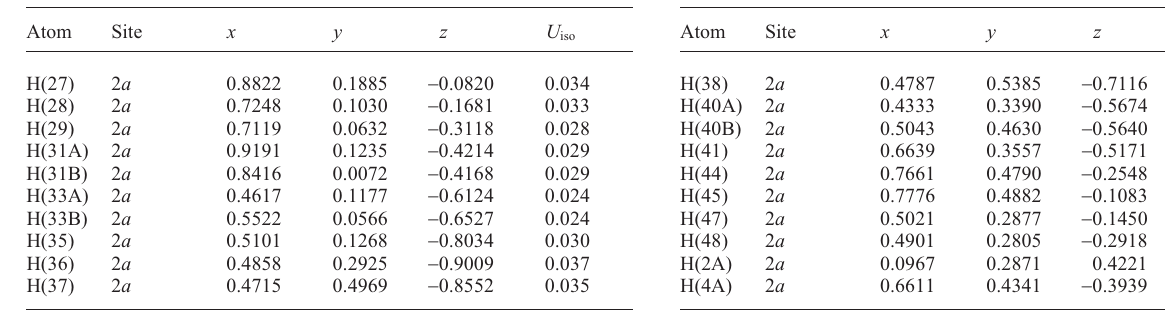
Table 3. Atomic coordinates and displacement parameters (in Å 2 )